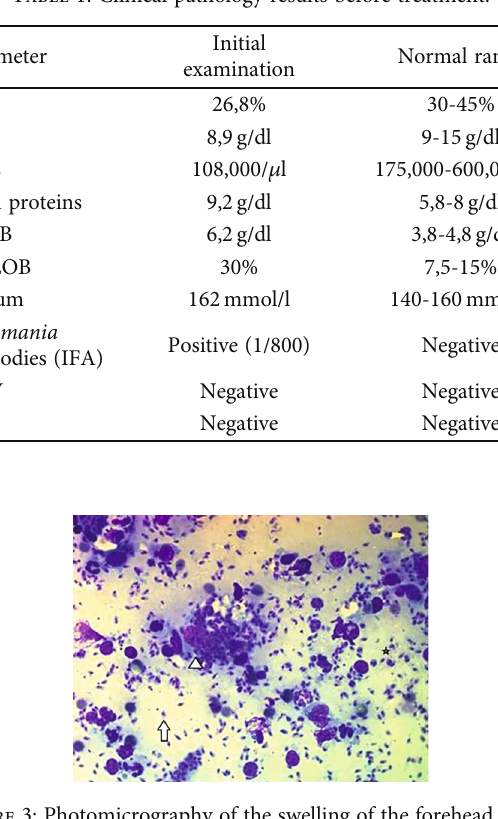
Table 1: Clinical pathology results before